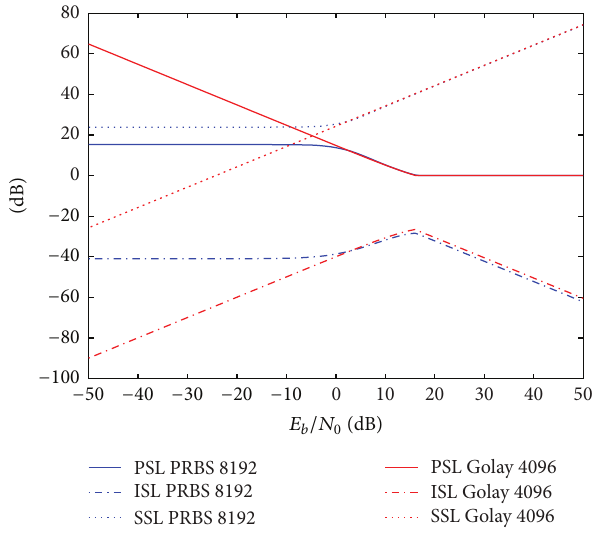
Figure 1: PSL, SSL, and ISL comparison for 4096-Golay and 8192- PRBS